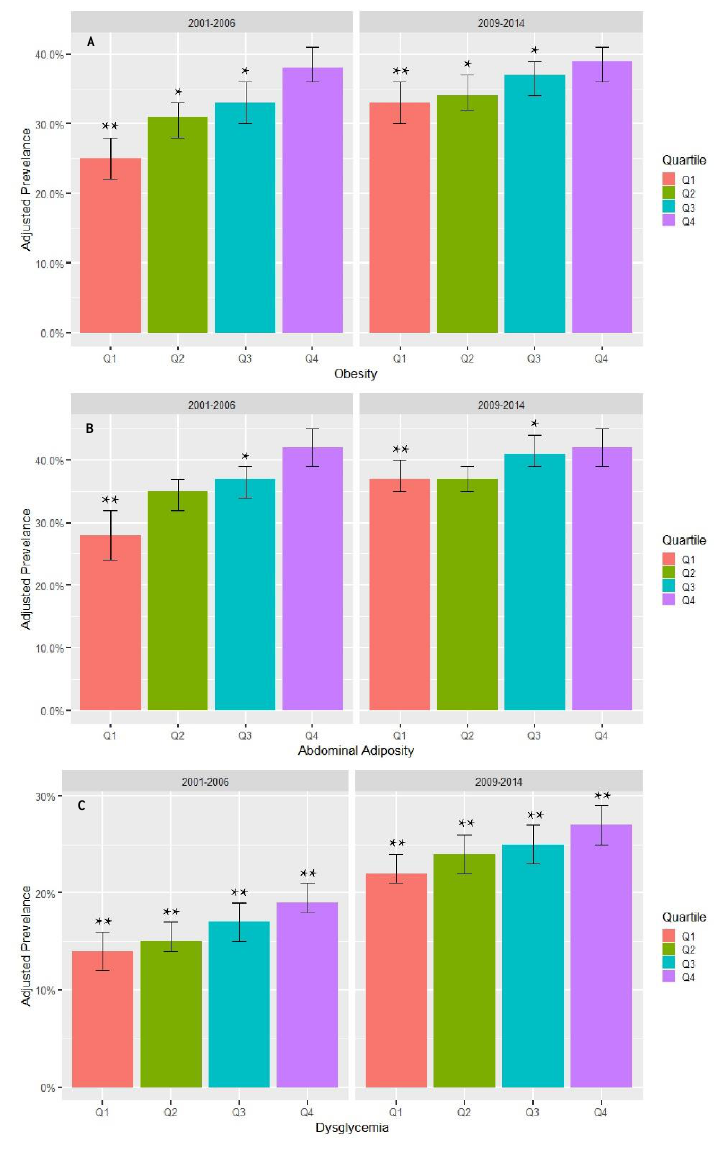
Figure 3. Adjusted prevalence of obesity ( A ), abdominal adiposity ( B ), and dysglycemia ( C ) by subsidy score quartile in the National Health and Nutrition Examination Survey between 2001–2006 and 2009–2014. Subsidy score quartiles were defined as follows: Q1 is 0.00–0.41; Q2 is 0.42–0.53; Q3 is 0.54–0.63; and Q4 is 0.64–1.00. Obesity was defined as a body mass index of at least 30 kg/m 2 .